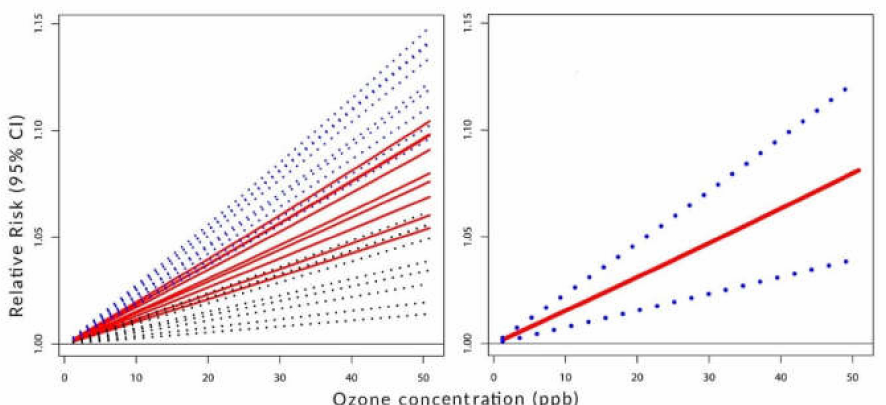
Figure 2. Left panel : C-RF shapes by lags. Right panel : a pooled C-RF shape. No transformation ( f ( Z ) = Z )